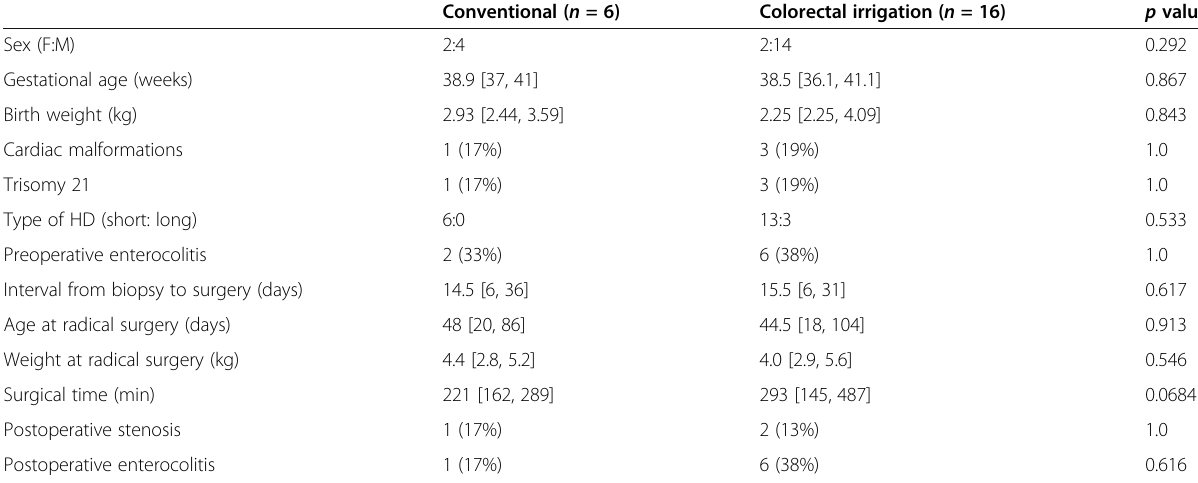
Table. 1 Comparison of background and perioperative factors between the conventional management group and tube management